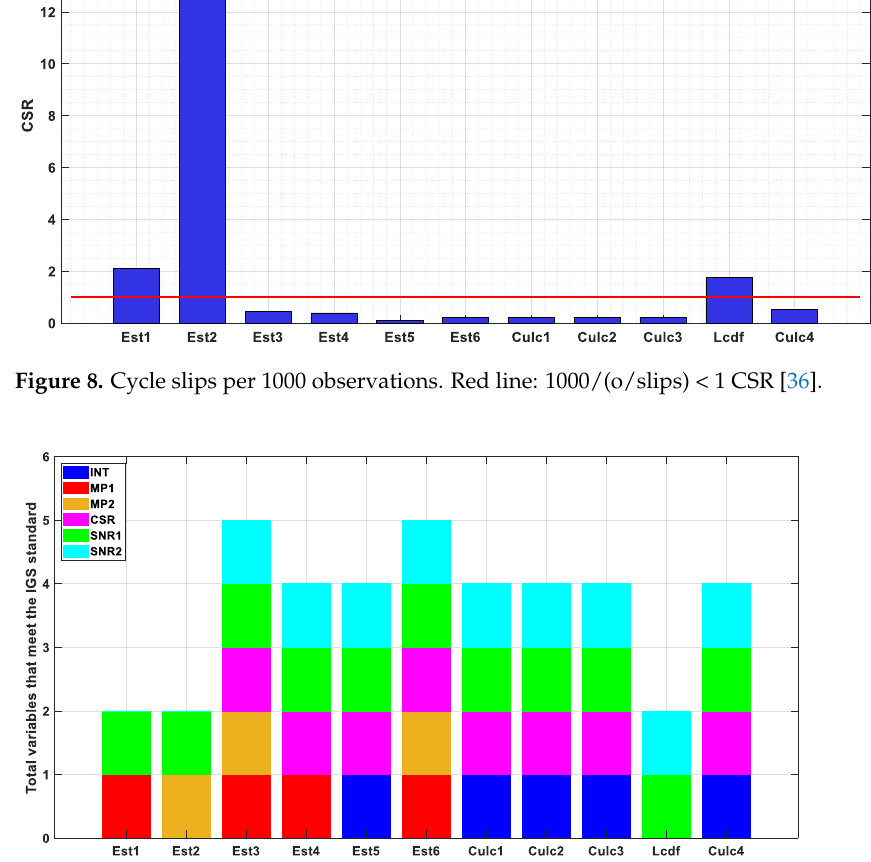
Table 6. Results of the CEP and EPV of Precise Point Positioning according to the INEGI technical standard. Station